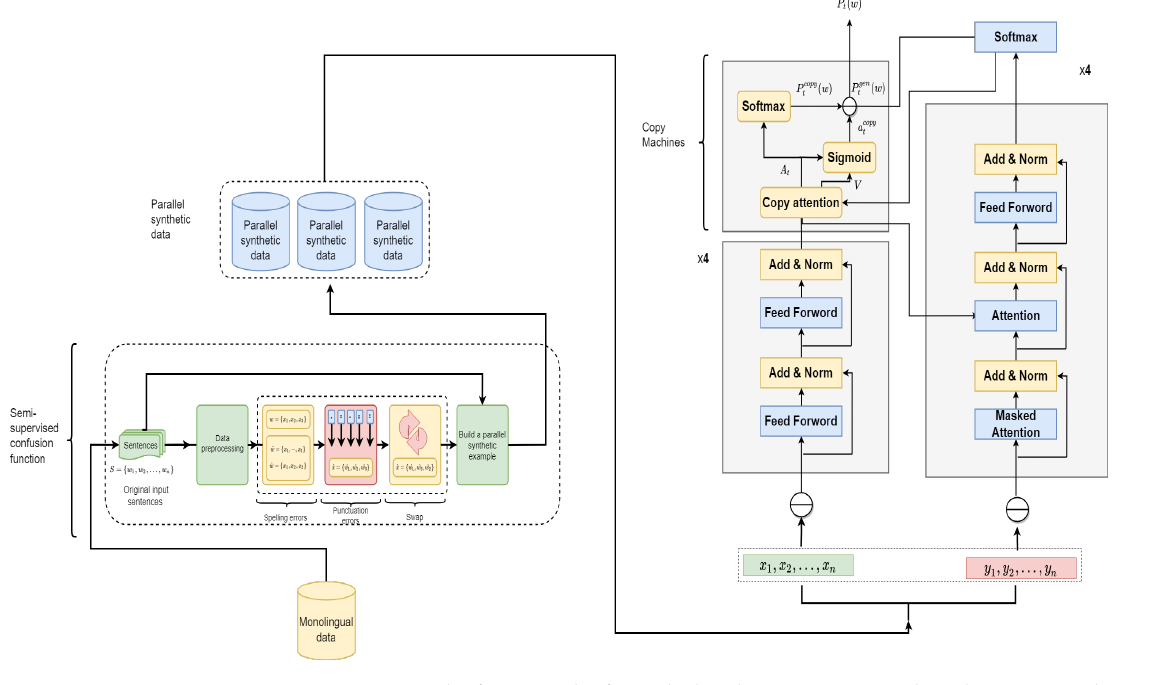
Figure 3. The framework of a multi-head attention network with a copy